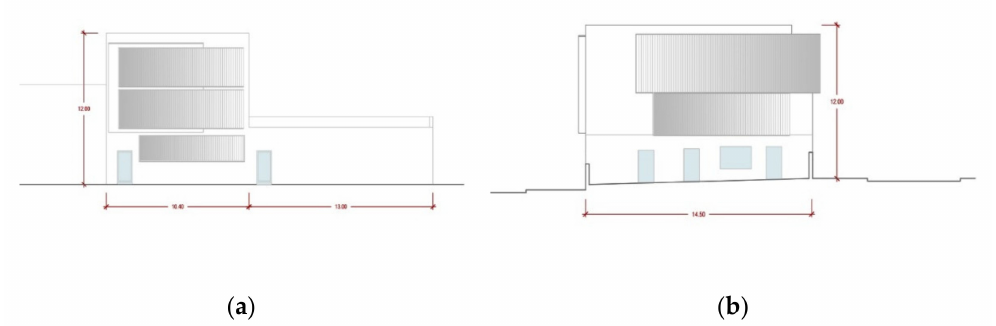
Figure 6. ( a ) Renovation: south-west elevation—proposal; ( b ) renovation: south-east elevation— current state.